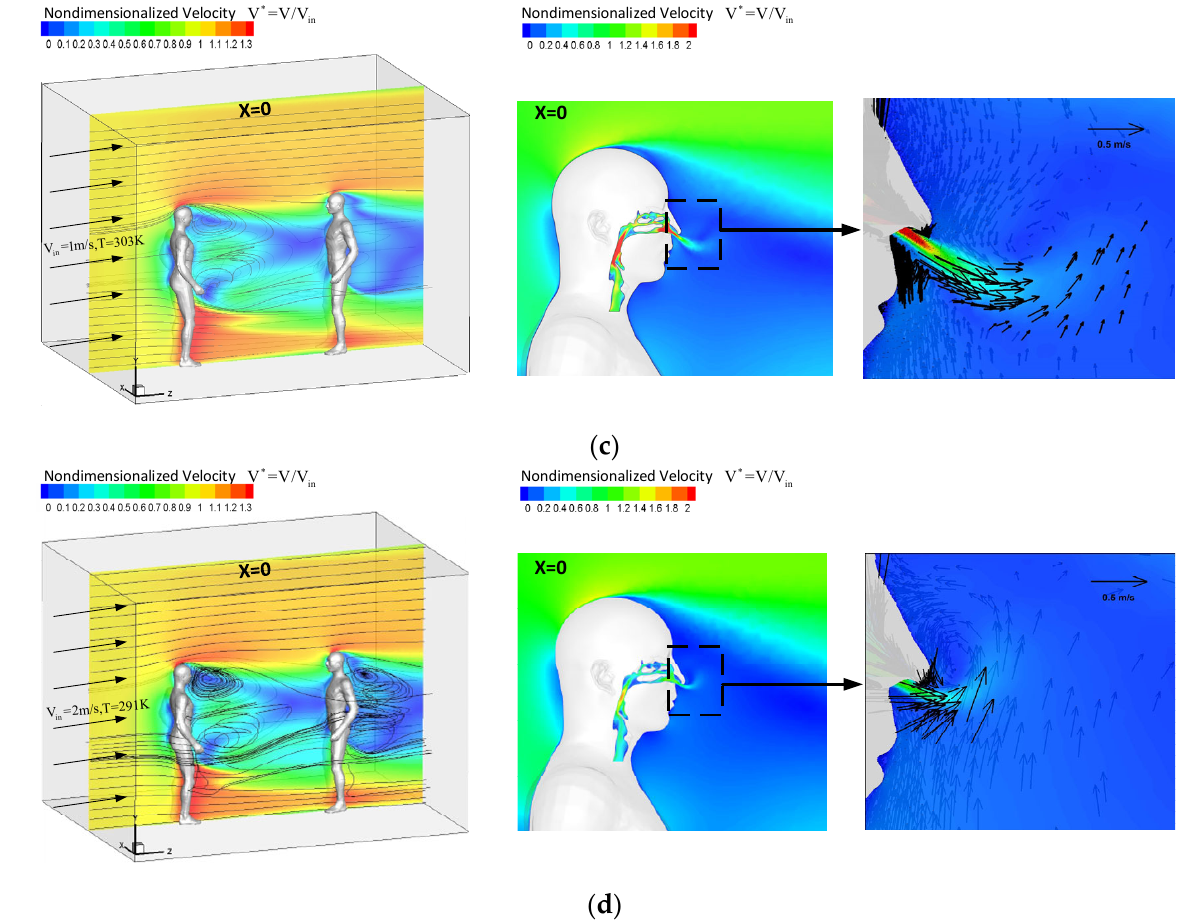
Figure 5. The initial contour line of dimensionless wind speed (V* = V/V in ) at plane X = 0 and local enlarged cloud map and vector map under different conditions: ( a ) V in = 1 m/s, T = 291 K, NCA; ( b ) V in = 1 m/s, T = 291 K, CA, ( c ) V in = 1 m/s, T = 303 K, CA; ( d ) V in = 2 m/s, T = 291 K, CA.